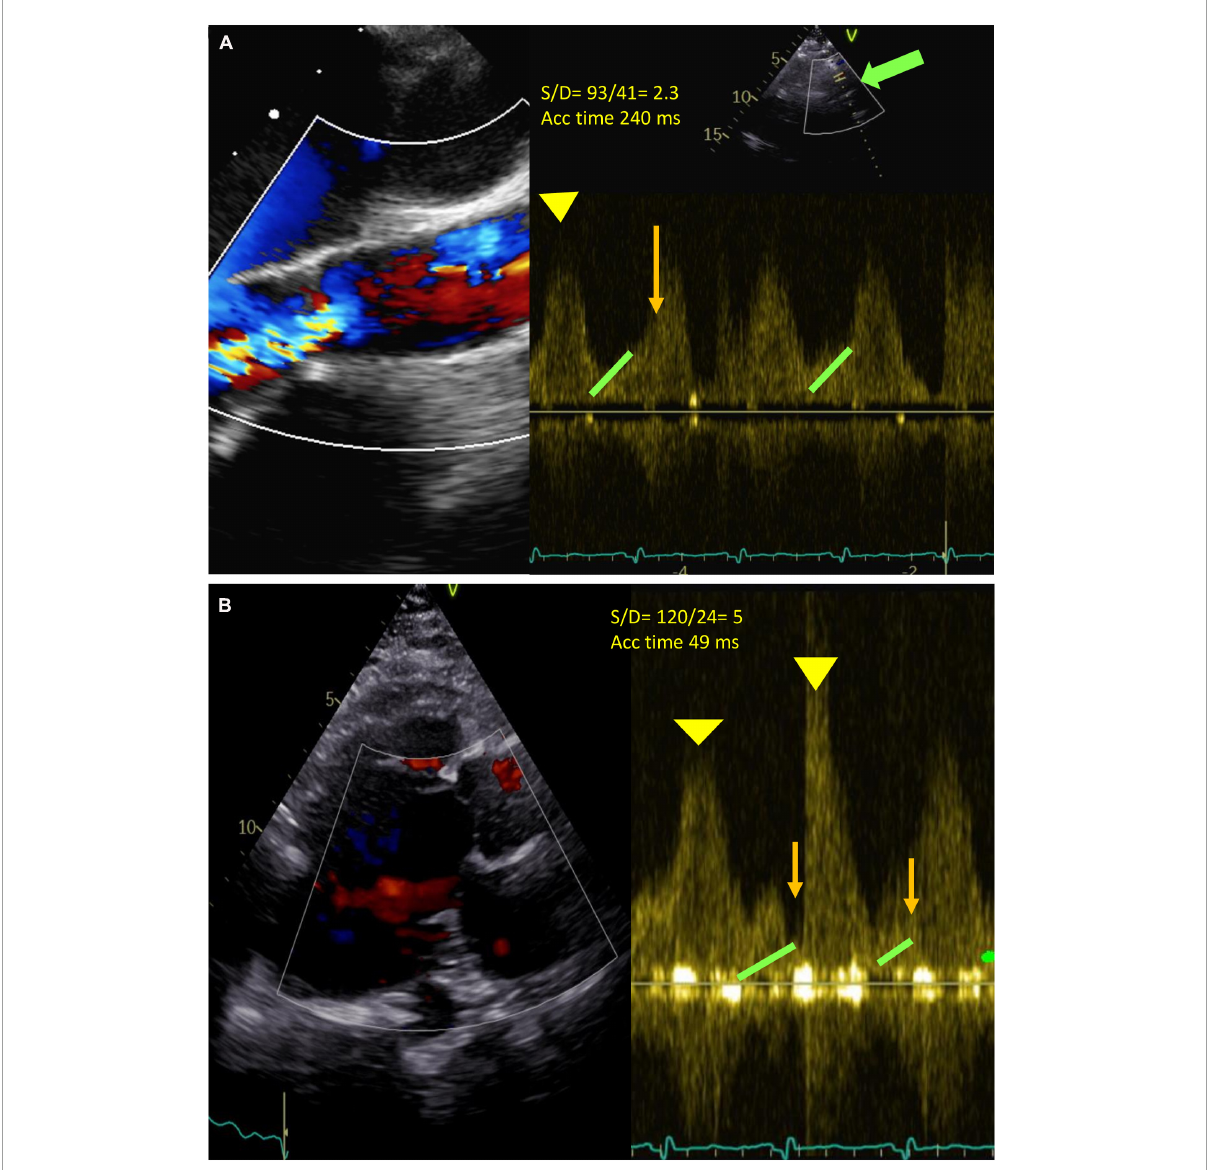
FIGURE3 (A) Severe continuous (holo-systolic and holo-diastolic) aortic regurgitation (AR). Green arrow: outflow cannula. Pulse Doppler (PW) at about 1 cm from the outflow cannula (bold green arrow). Diastolic acceleration time 49 ms (orange line), S/D ratio 93/41 = 2.3 ( < 5 significant AR) (Yellow head arrow: systolic wave; green head arrow: end Diastolic velocity). Acceleration time 240 ms. (B) No AR. S/D 53/10 = 5. Acceleration time